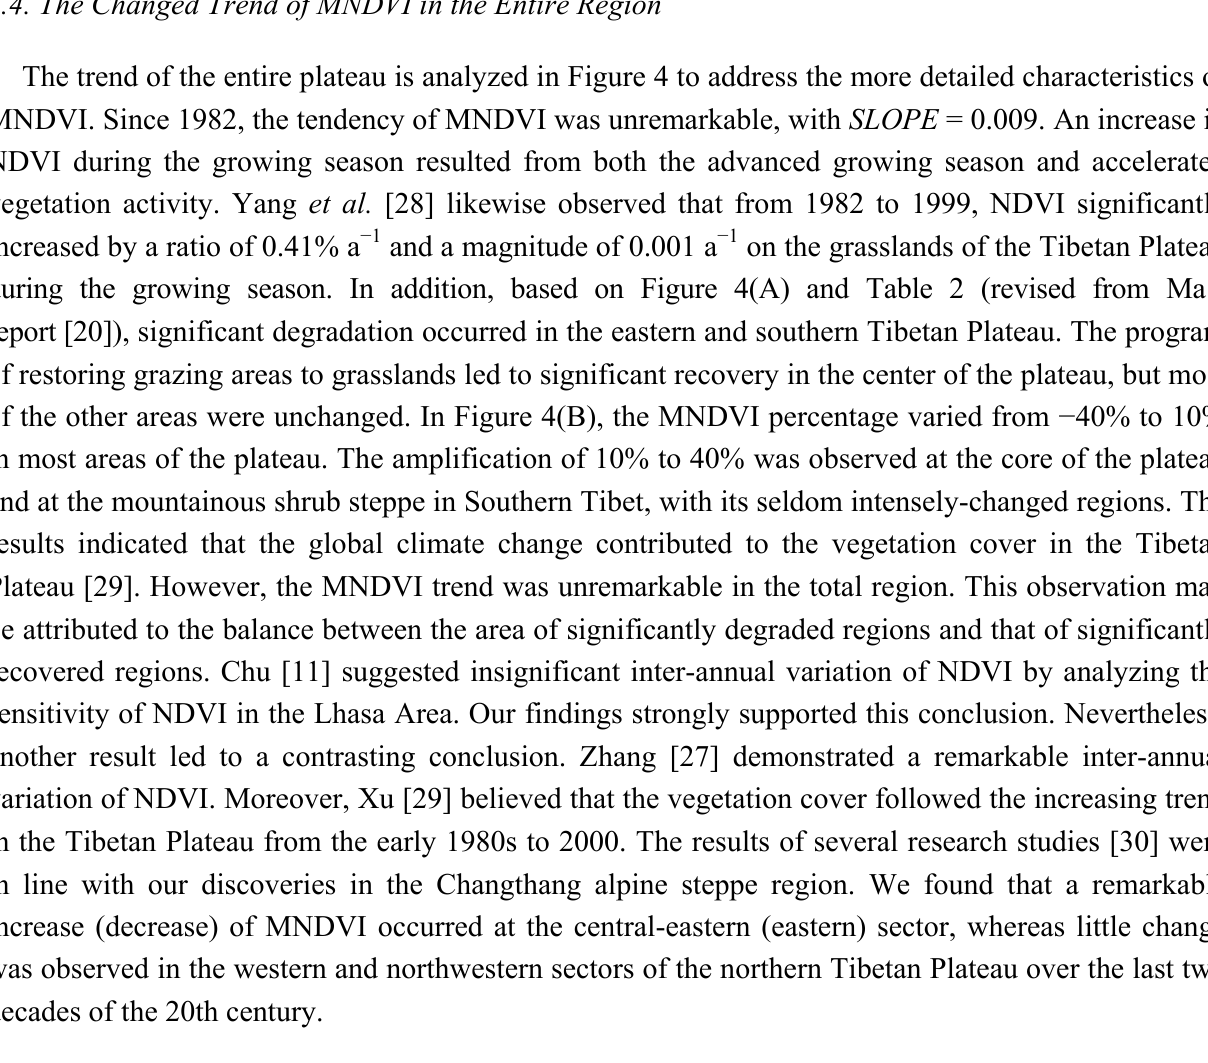
Table 2. Classified result of maximum Normalized Difference Vegetation Index (MNDVI) change simulated from 1982 to